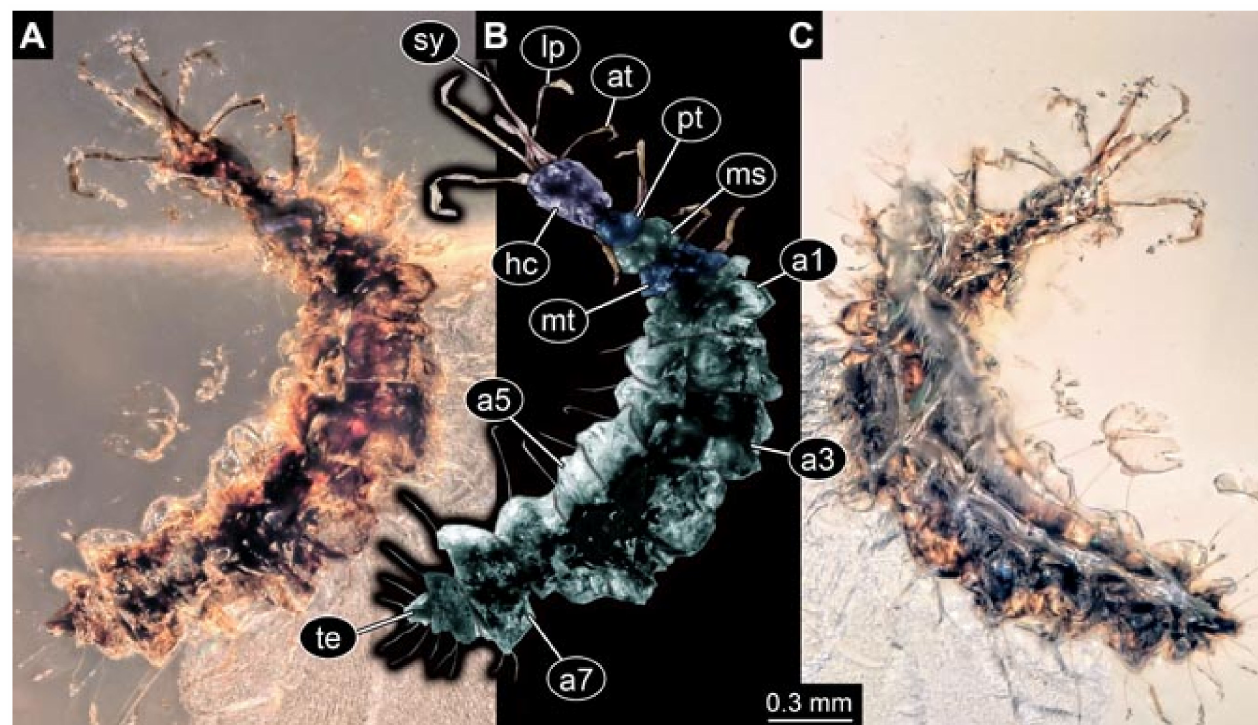
Figure 30. Specimen 5861 (PED 0627); Myanmar amber. ( A ) Dorsal view. ( B ) Dorsal view, colour-marked. ( C ) Ventral view. Abbreviations: a1–a7 = abdomen segments 1–7; at = antenna; hc = head capsule; lp = labial palp; ms = mesothorax; mt = metathorax; pt = prothorax; sy = stylet; te = trunk end.